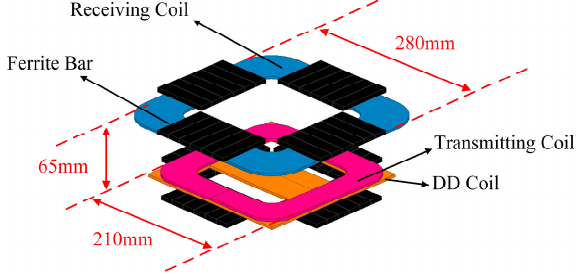
Figure 5. 3D model of the LCT. Table 2. Simulation values for compensation inductance and LCT.